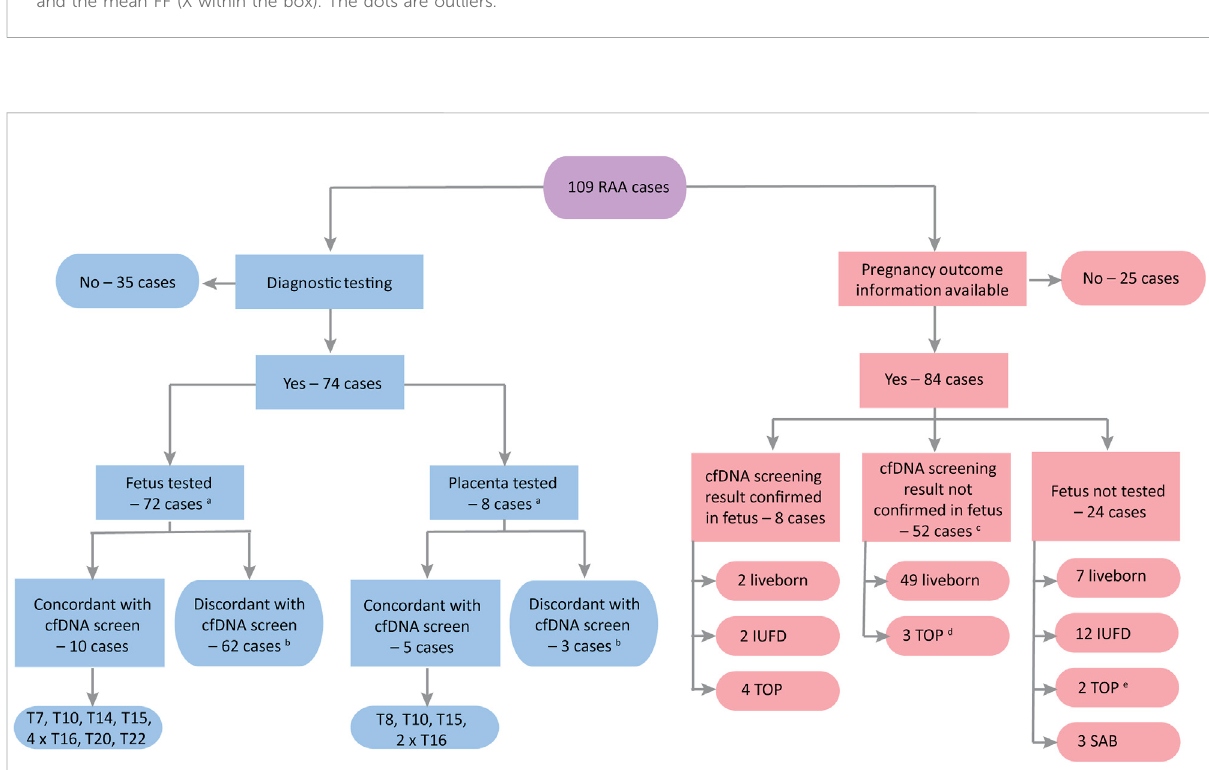
FIGURE 3 Flowchart of outcomes for the study cohort ( n = 109). IUFD, intrauterine fetal demise; PX, pregnancy; SAB, spontaneous abortion; TOP, termination of pregnancy. a Six cases underwent both fetal and placental testing. b In two cases the cfDNA screening result was discordant with both fetus andplacenta. c The cfDNA screening result was con fi rmedin placental tissue infour ofthese cases: three liveborn(trisomy8case with FGR and premature birth; trisomy 16 case with spontaneous premature birth; trisomy 16 case with induced premature birth for preeclampsia) and one selective TOP (trisomy 15 with severe FGR). d The other two TOP cases were a trisomy 20 case with multiple abnormalities noted on autopsy and a trisomy 7 case with cleft lip/palate identi fi ed on ultrasound following the cfDNA screen. e One case (trisomy 7) had a mutation in SLC12A6; the other case (trisomy 8) had abnormalities but no further details are available.